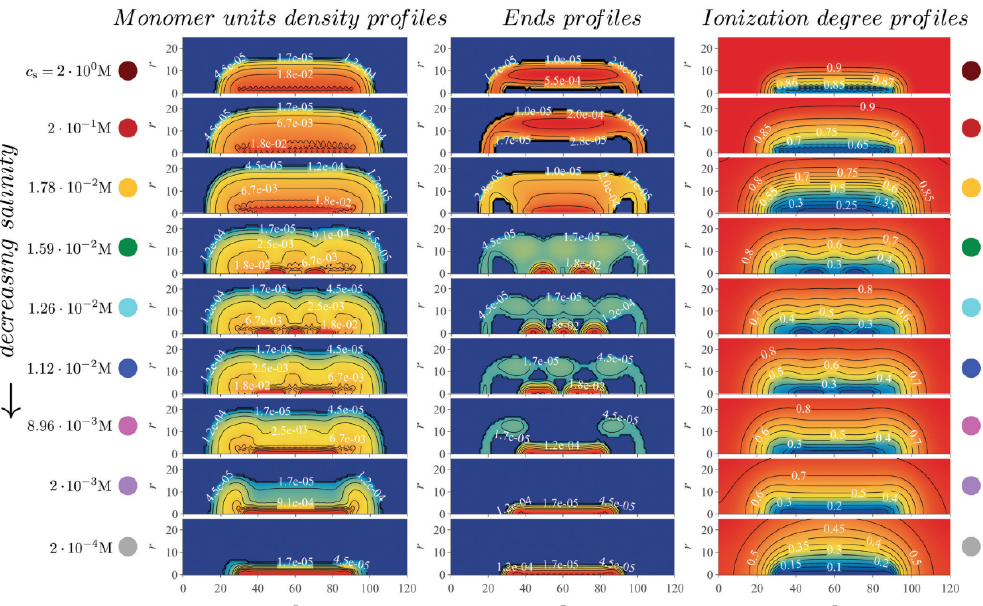
Figure 6. Molecular brush consisting of a semi-rigid polyelectrolyte (PE) backbone with N = 61 monomers and 21 flexible side chains with N = 30 monomers immersed in a aqueous solution. Monomers are weak polyacids. Panels correspond to the spacial distribution of the monomers (left), that of the terminal groups (middle) and the ionization degree (right), at different salt concentrations, as indicated in the graph. pH − pK a = 1 and solvent quality parameter χ = 1.5. The distributions show changes in the density from denser (red color) to less dense (blue color). (Reprinted with